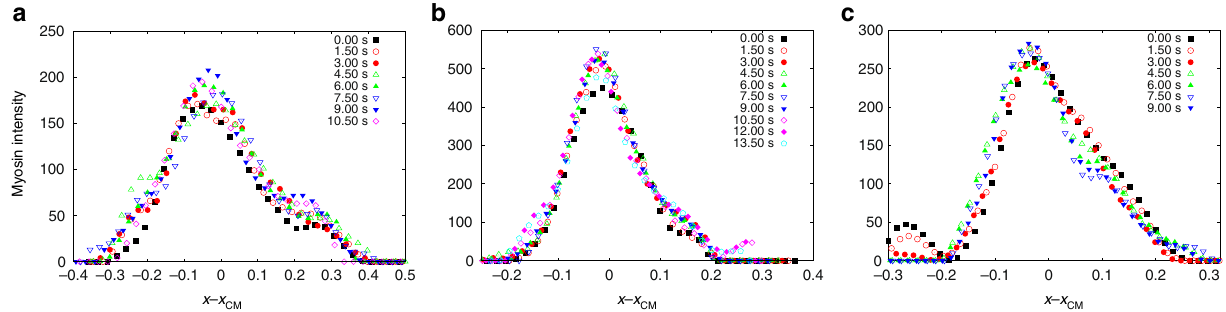
Fig. 8 Spatial pro fi le and movement of myosin dense regions: Excess bound myosin density in the moving frame. a – c Three separate examples of the spatial pro fi le of myosin intensity in the co-moving frame of the fl owing actomyosin-dense cluster displayed at different times. Note that the actomyosin- dense cluster hardly changes its shape as it fl ows towards a junction